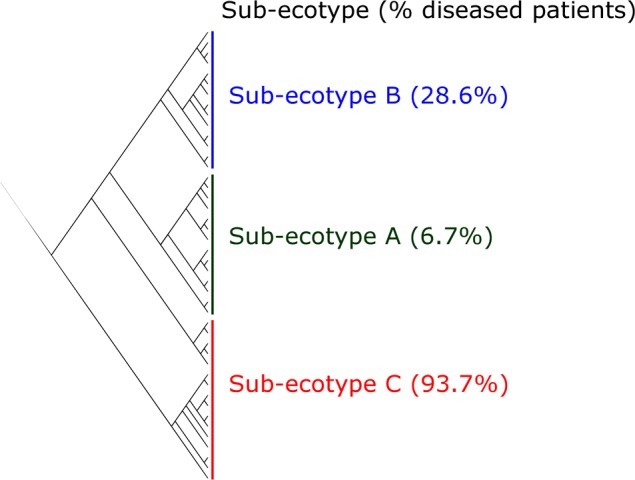
Clustering of the ecotype 2 based on Bray–Curtis distances. The ecotype 2 was clustered in three sub-ecotypes (A–B–C) based on k-means algorithm (1000000 iterations). One sample was alone in a fifth cluster and was removed. The optimal number of clusters was assessed with the gap statistic (Supplementary Figure S2). Indicated is the percentage of diseased patients in the respective sub-ecotypes.